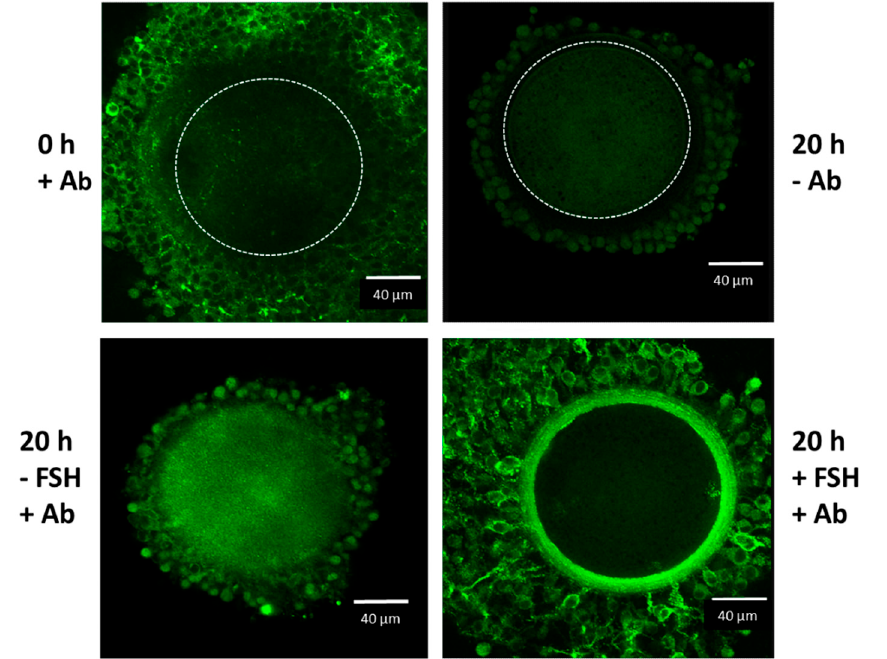
Figure 2. Confocal microscope analysis of I α I in the oocyte-cumulus complexes. Oocyte–cumulus cells complexes were analyzed at the beginning (0 h) and at the end (20 h) of the culture carried out in the presence of 5 % FBS, with or without FSH (100 ng/mL) stimulation, as indicated. Immunoreactivity for I α I components was evident in the ECM structure organized around the cumulus cells after FSH stimulation by using a rabbit anti-human I α I antibody (Ab dilution 1:100; DAKO, Carpenteria, CA, USA) and Alexa Fluor 488 goat anti-rabbit IgG as a secondary antibody (dilution 1:500; Molecular Probes, green). In A and B, the boundary of the oocyte is marked by a dashed line.